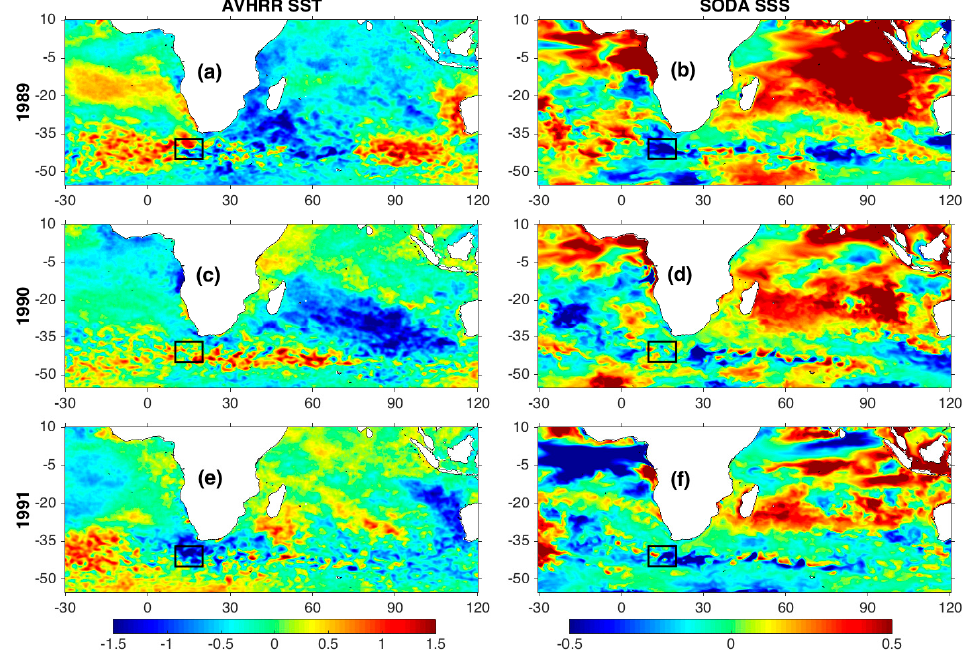
Figure 4. Composite mean for strong 1988–1989 La Niña event from January-March for both AVHRR SST anomalies (left column) and SODA SSS anomalies (right column) during the peak ( a , b ), the following year ( c , d ), and two years after ( e , f ). The boxes represent the established leakage region (37–45 ◦ S, 10–20 ◦ E).